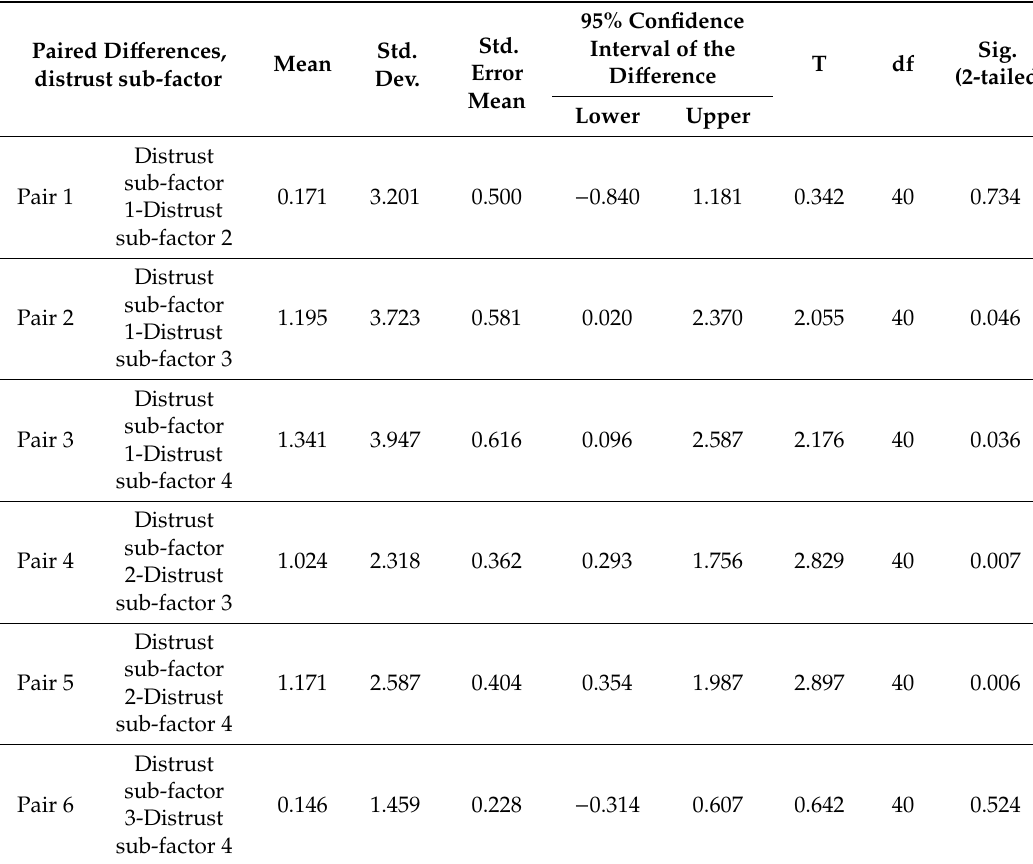
Figure 6. Trust scores as a separated subset from [75]. Table 3. Post-hoc tests for the Distrust